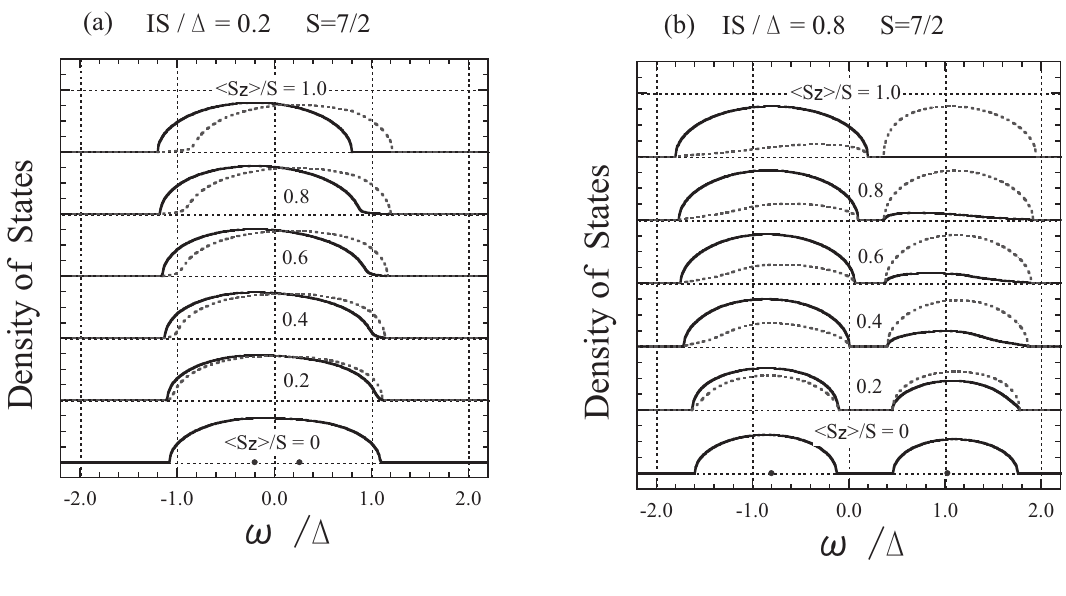
Figure 2. The DOS shown for magnetizations ⟨ S and 1.0: (a) IS= ∆ = 0 : 2 (left panel) and (b) IS= ∆ = 0 : 8 (right panel). The solid curves show up-spin states and the dotted curves show down-spin